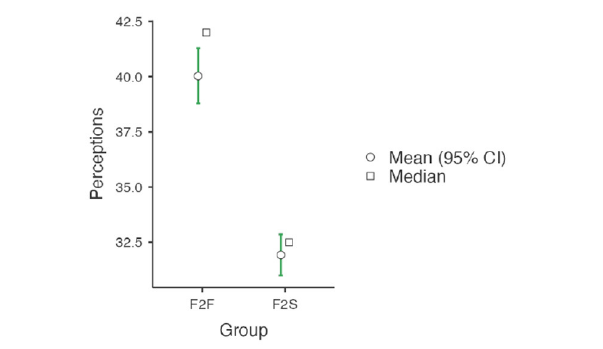
FIGURE 4 | Perception analysis of F2F and F2S flipped classroom after the course